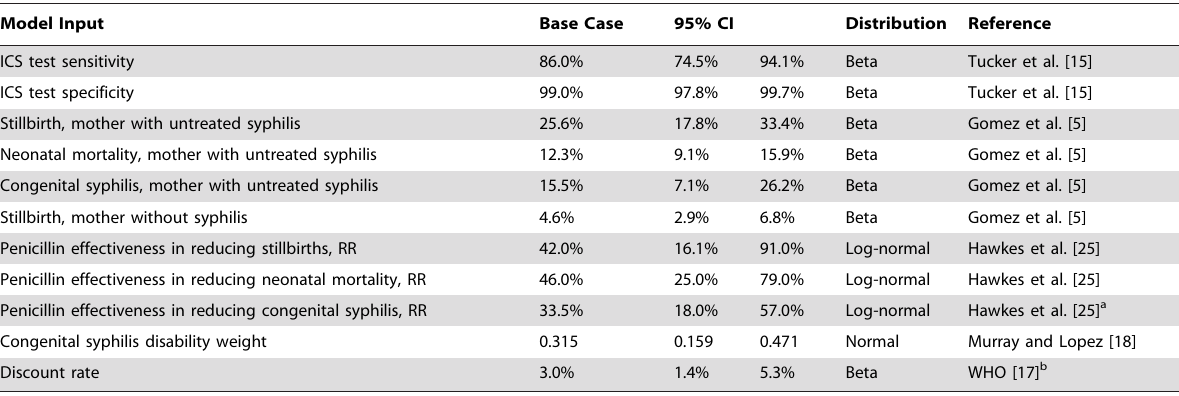
Table 1. General model